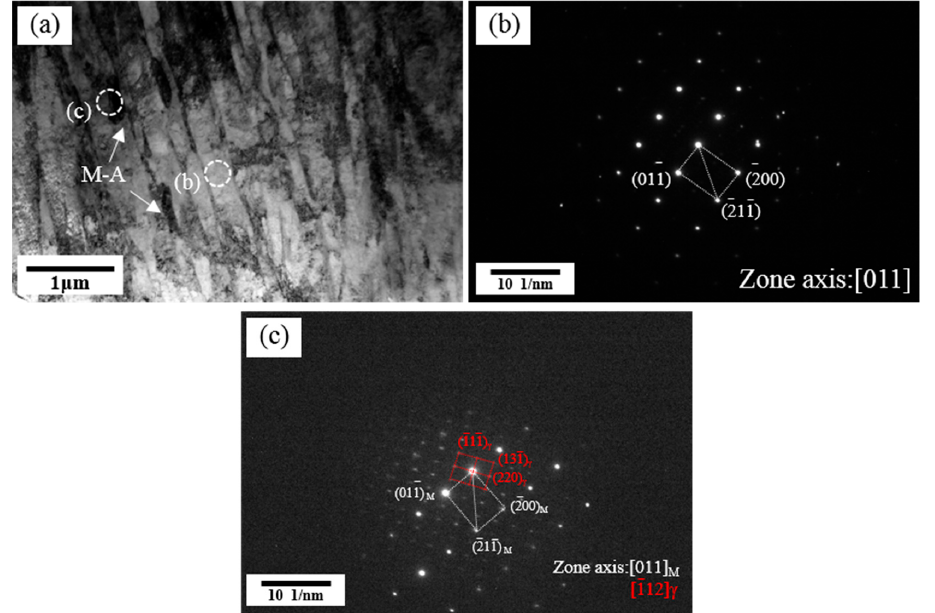
Figure 7. TEM micrographs of microstructure in the simulated CGHAZ at a peak temperature of 1350 °C: ( a ) microstructure, ( b ) corresponding SADP for martensite, ( c ) corresponding SADP for M-A constituent.